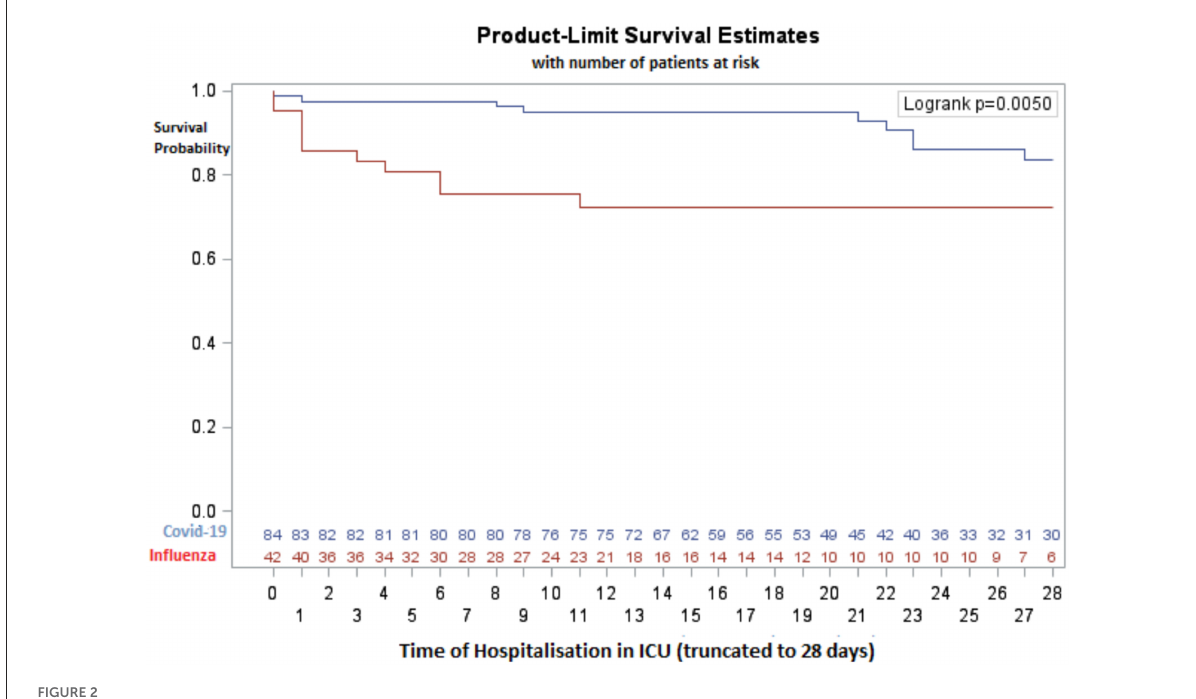
FIGURE2 Probability of survival (Kaplan-Meyer